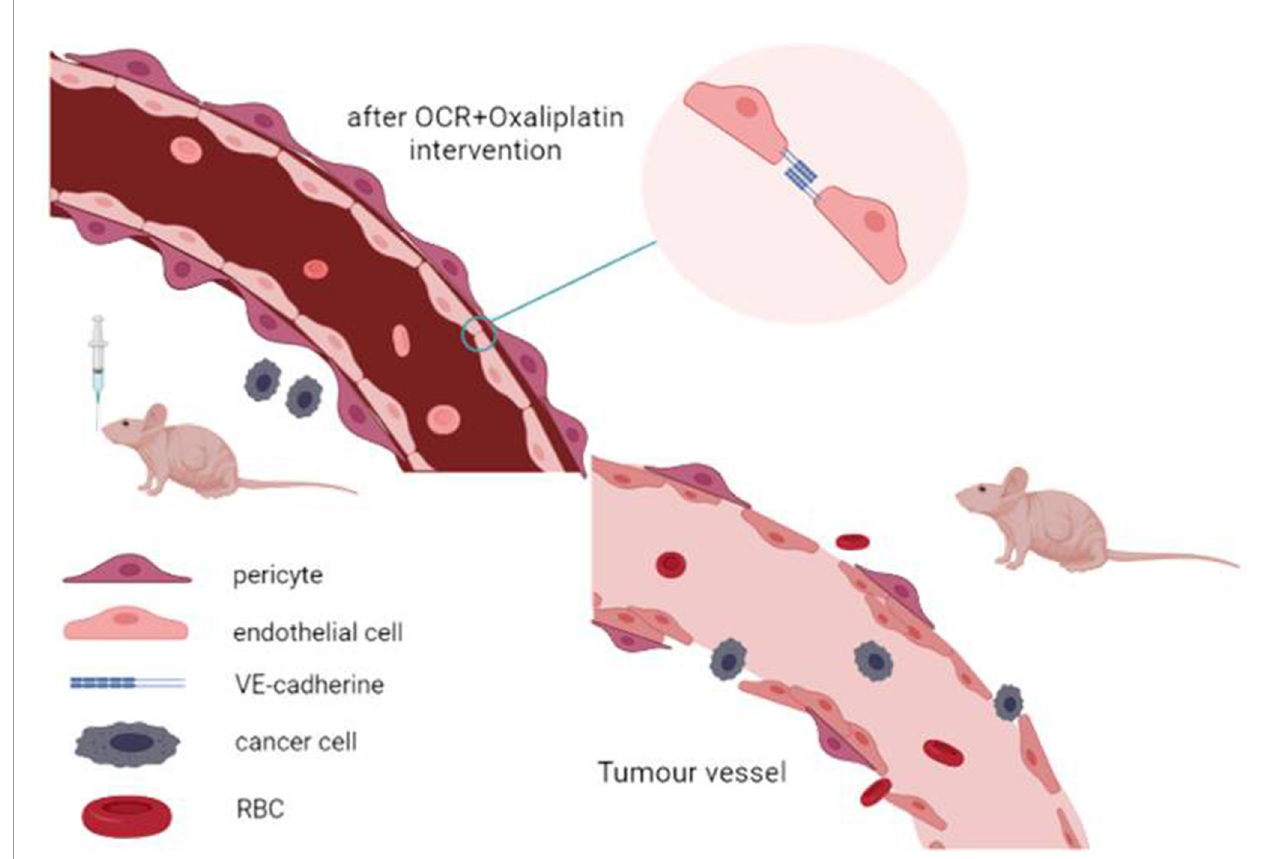
FIGURE 7 | Conclusion